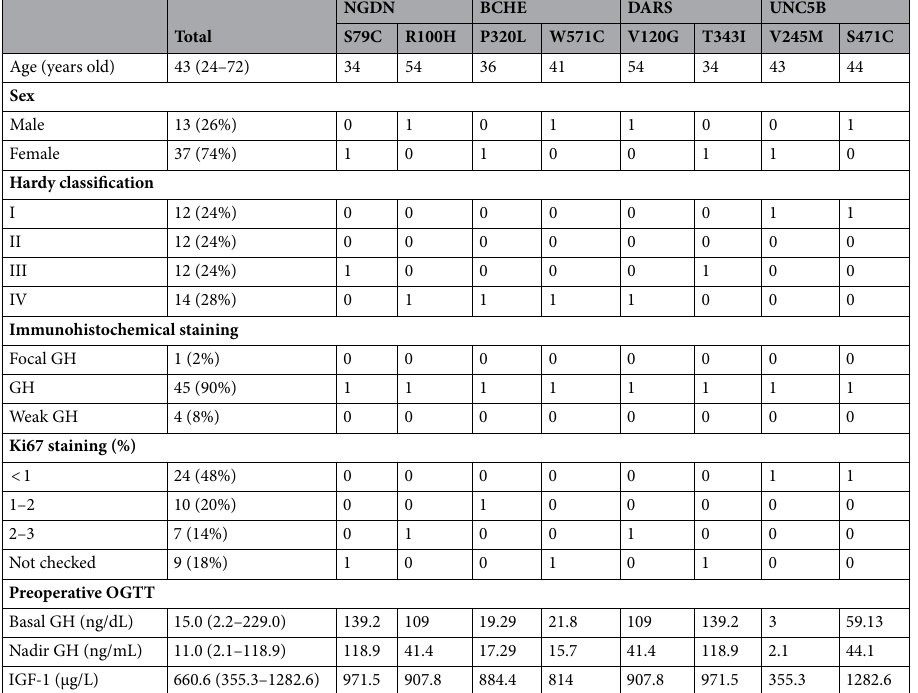
Table 1. Clinical characteristics of patients with somatic variants in growth hormone (GH)-secreting pituitary